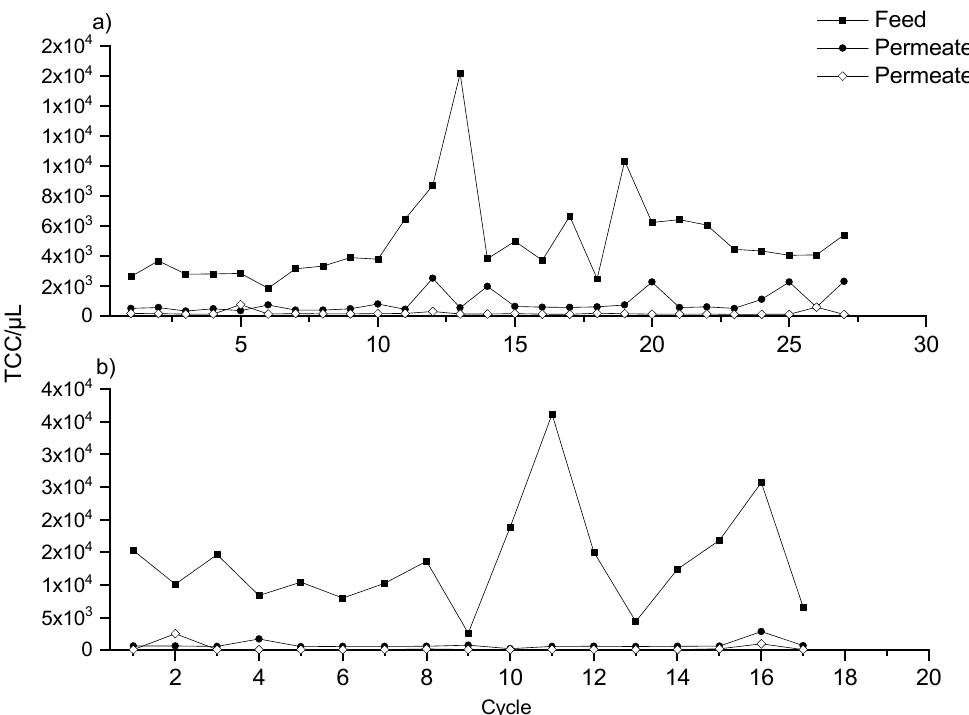
Figure 7. Continuous determination of total cell count (TCC) in Elbe River water (feed), Permeate 1 and Permeate 2, ( a ) 26 April–29 May 2019, ( b ) 2 May–4 May 2019, samples were stained with SYBER® Green and propidiumiodide.